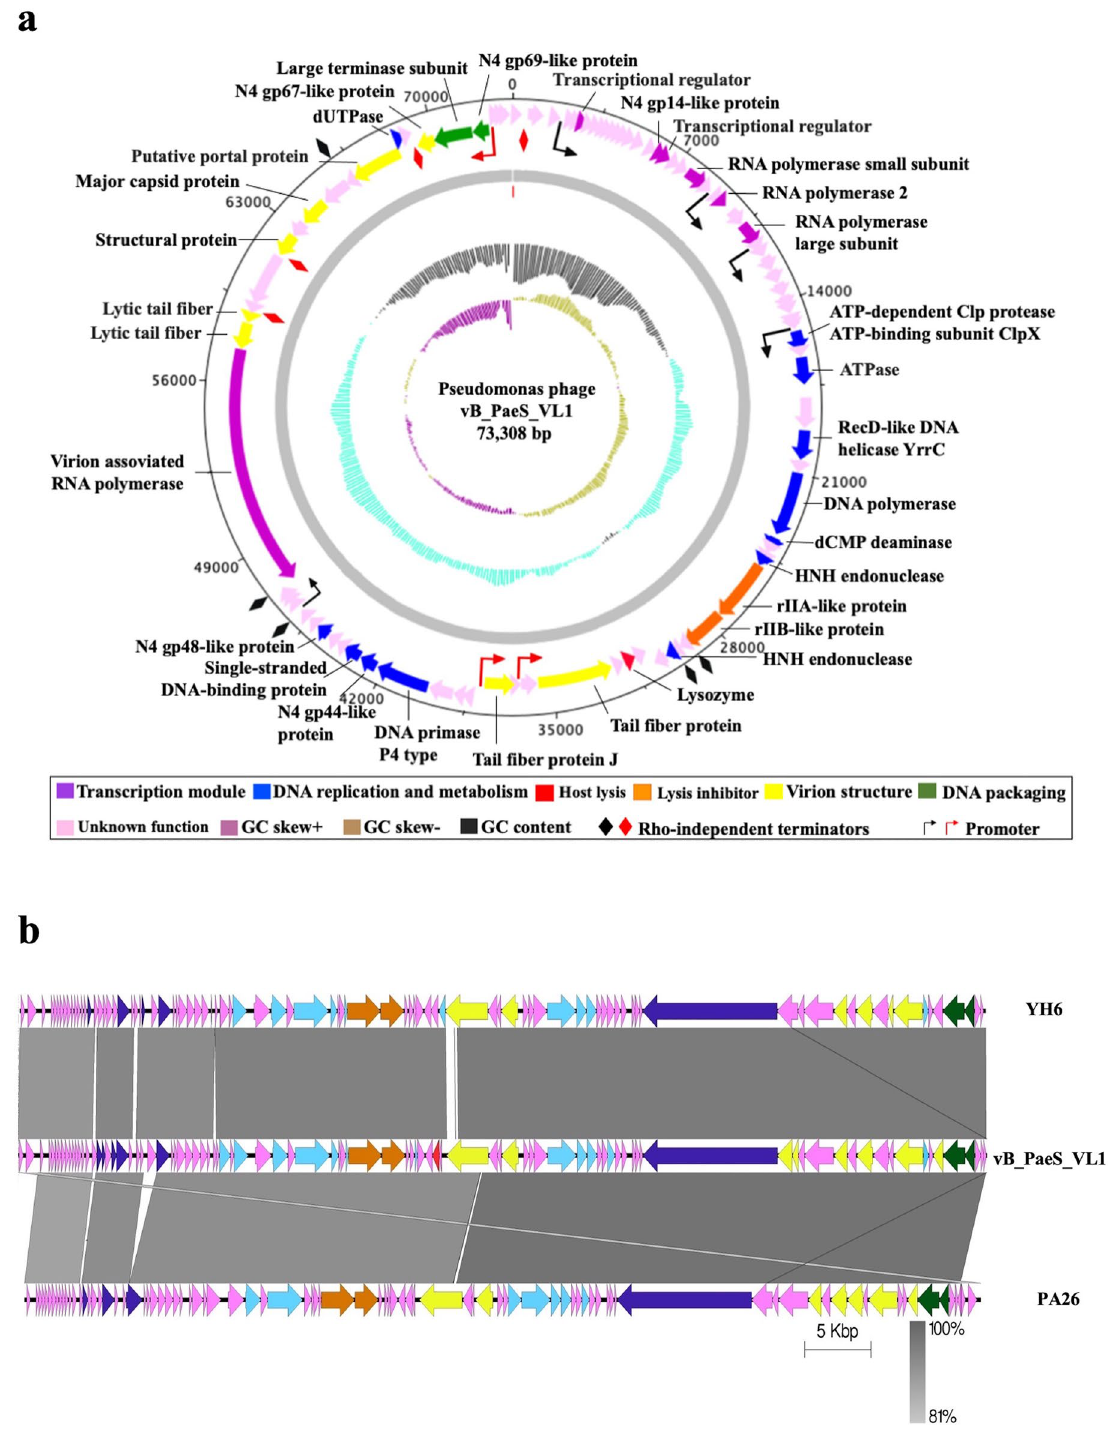
Figure 2. Phage vB_PaeS_VL1 whole genome analysis. ( a ) Map of genome organization of phage VL1. The outer ring shows a total of 92 open reading frames (ORFs) with their transcription direction and highlighted with different colors according to their functions. This circular map was generated using Artemis version 17.0.1. ( b ) Comparison of the whole genome sequences of the phage VL1 with similar phages ( Pseudomonas YH6 and PA26). The colored arrows indicated ORFs according to their predicted function. The homologous regions between phages are indicated by gray shading. (Scale = base